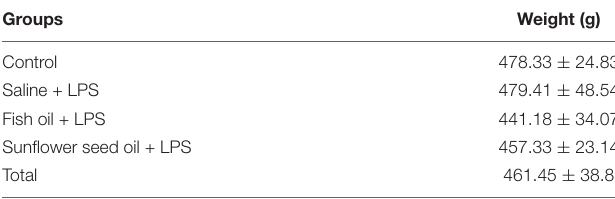
TABLE 1 | Mean body weight of rats of four